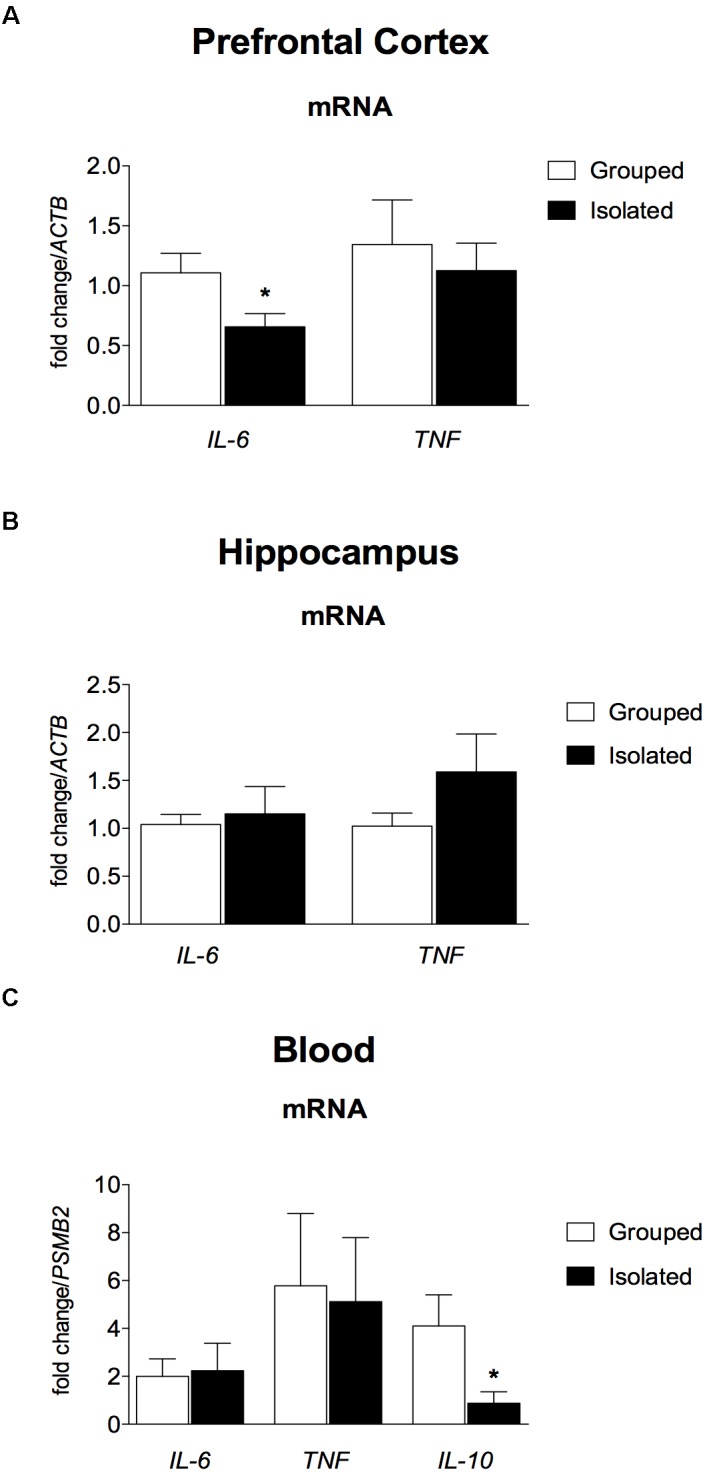
Effect of rearing condition (isolated vs. grouped) on cytokines gene expression in the pre-frontal cortex, hippocampus, and peripheral blood of rats after 10 weeks of social isolation. (A) Prefrontal Cortex: Isolated-reared rats (n = 9) presented reduced IL-6 mRNA in the prefrontal cortex when compared to controls (n = 10). (B) Hippocampus: No difference was found for isolated (n = 9) or grouped-reared (n = 10) rats in IL-6 or TNF mRNA. (C) Peripheral blood: Isolated-reared rats (n = 7) had reduced IL-10 mRNA in peripheral blood leucocytes than controls (n = 7). Cytokine mRNA expression was measured by qRT-PCR. Data are expressed as mean fold change ± S.E.M in mRNA levels using the housekeeping genes (ACTB, PSMB2) as reference. ∗p < 0.05 (Student’s t-test) compared to grouped rats.